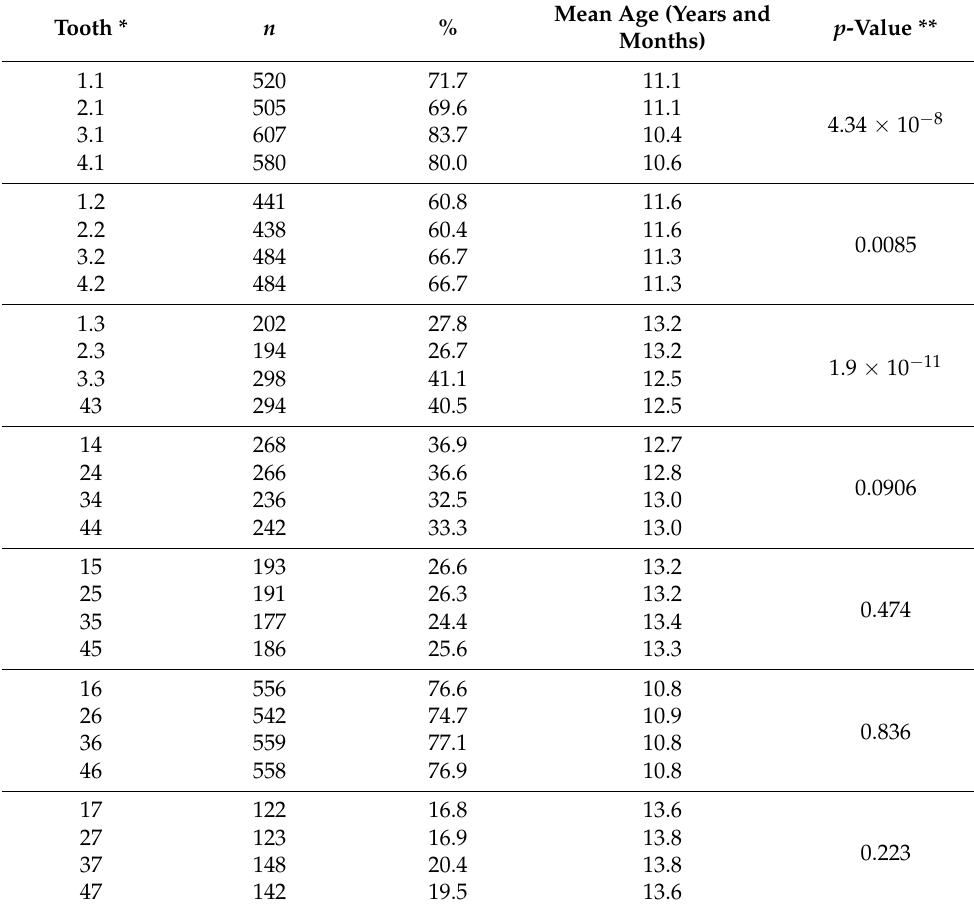
Table 1. Chronology of the eruption of all the permanent dentition except for the wisdom teeth by age in years and months.